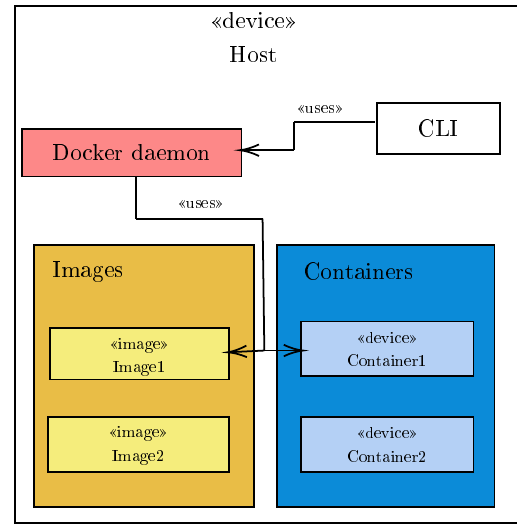
Fig. 1: An illustration representing hosting of docker artifacts together with command line interface (CLI) used for